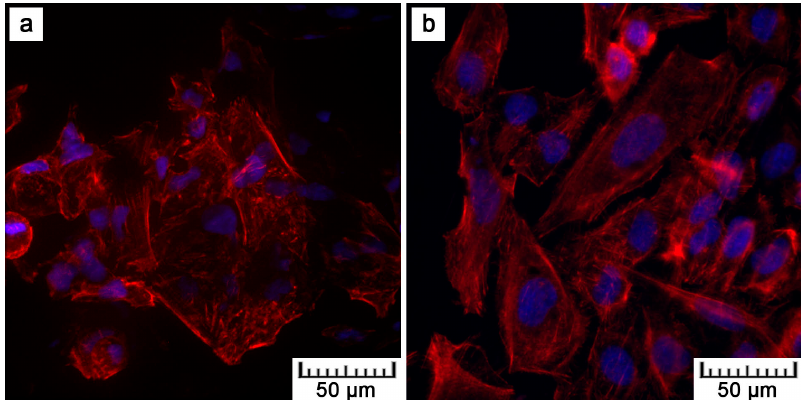
Figure 9. Cell morphology of U-2 OS cells cultivated on : ( a ) the plasma-treated sample; ( b ) ground control for four days (red—F-actin, blue—nuclei, magnification 400×).